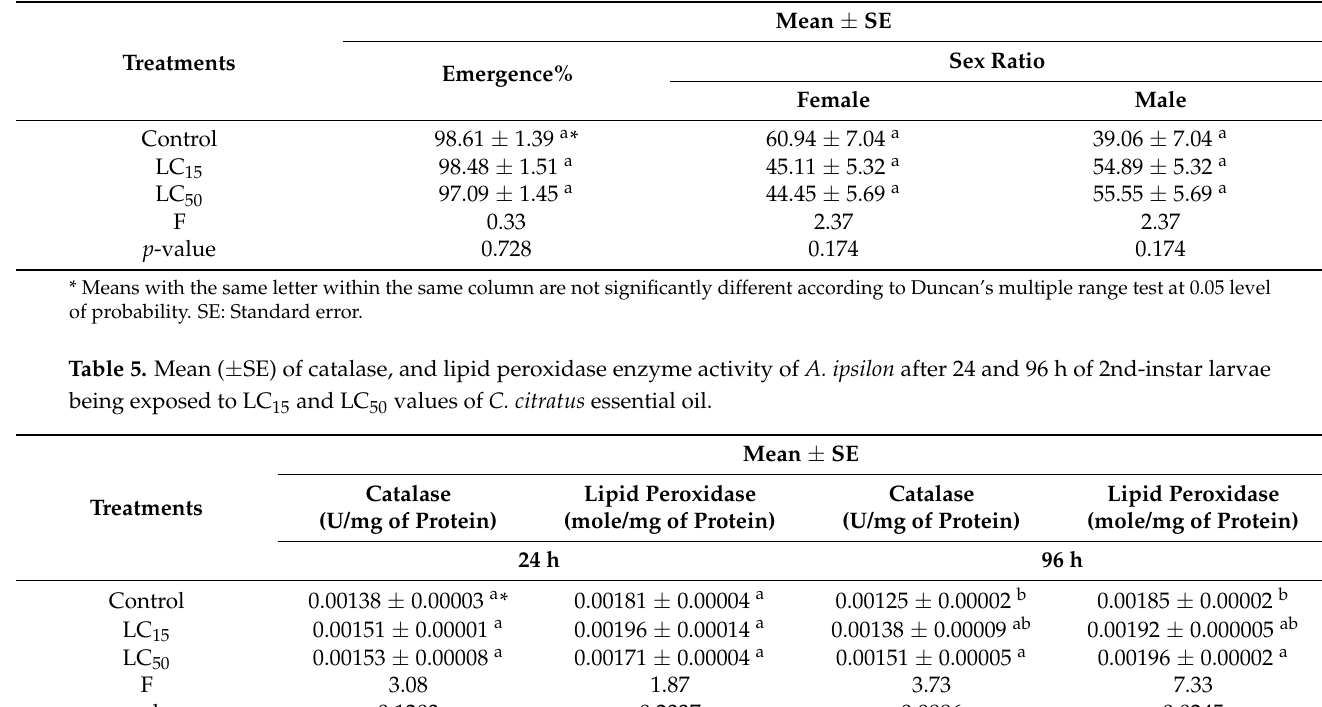
Table 4. Effects of C. citratus essential oil on the emergence %, and sex ratio after treating the 2nd-instar larvae of Agrotis ipsilon with LC 15 and LC 50 values.